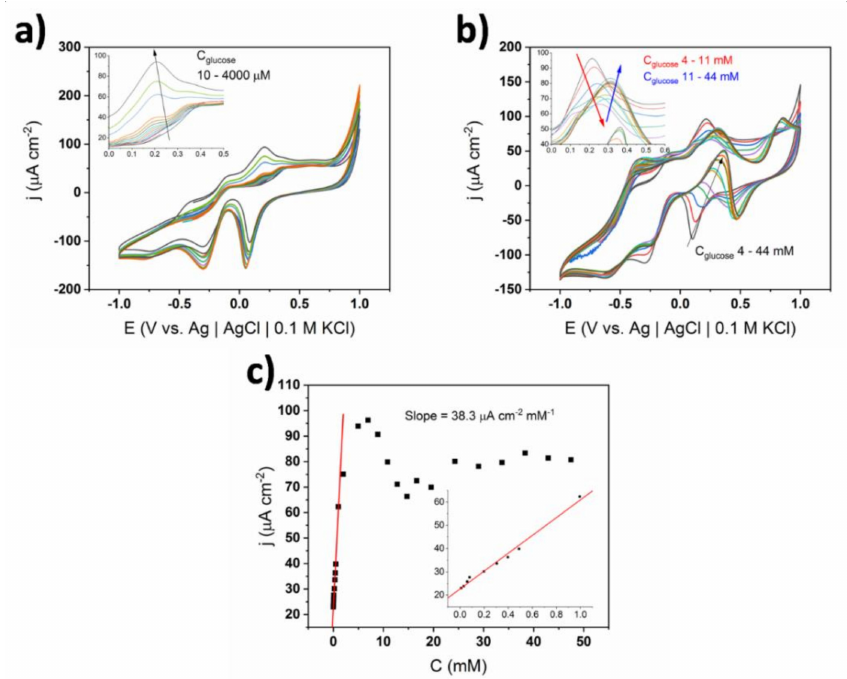
Figure 9. ( a ) and ( b ) Cyclic voltammograms of TiND | AuNP Nafion-coated electrode registered for di ff erent glucose concentrations in 0.1 X cPBS; insets—magnification of glucose oxidation peaks, ( c ) calibration curve based on glucose oxidation peak at + 0.35